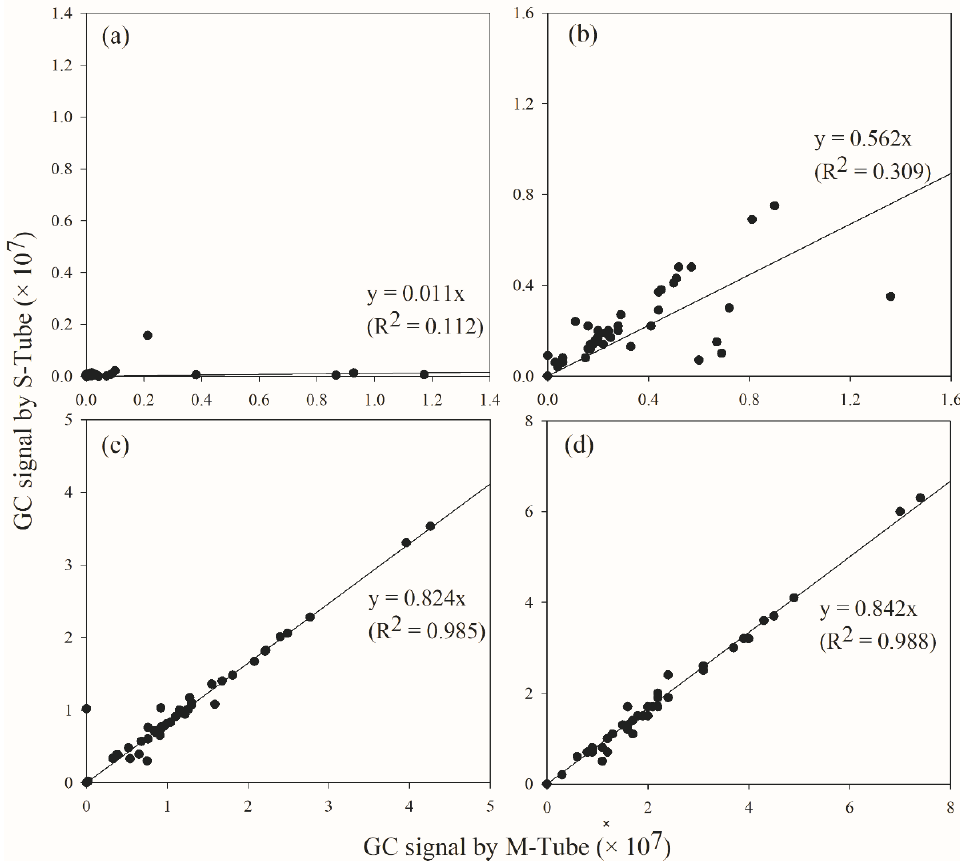
Figure 1. Comparison of GC-MS response intensity between the S-Tube ( y -axis) and the M-Tube ( x -axis) with four different retention concentrations ranging from 21.3 ng/tube to 21,302 ng/tube. Analysis was performed by thermal desorption coupled with GC/MS in scan mode and SIM mode: ( a ) Total mass: 21.3 ng/tube; ( b ) Total mass: 2130 ng/tube; ( c ) Total mass: 10,651 ng/tube; ( d ) Total mass: 21,302